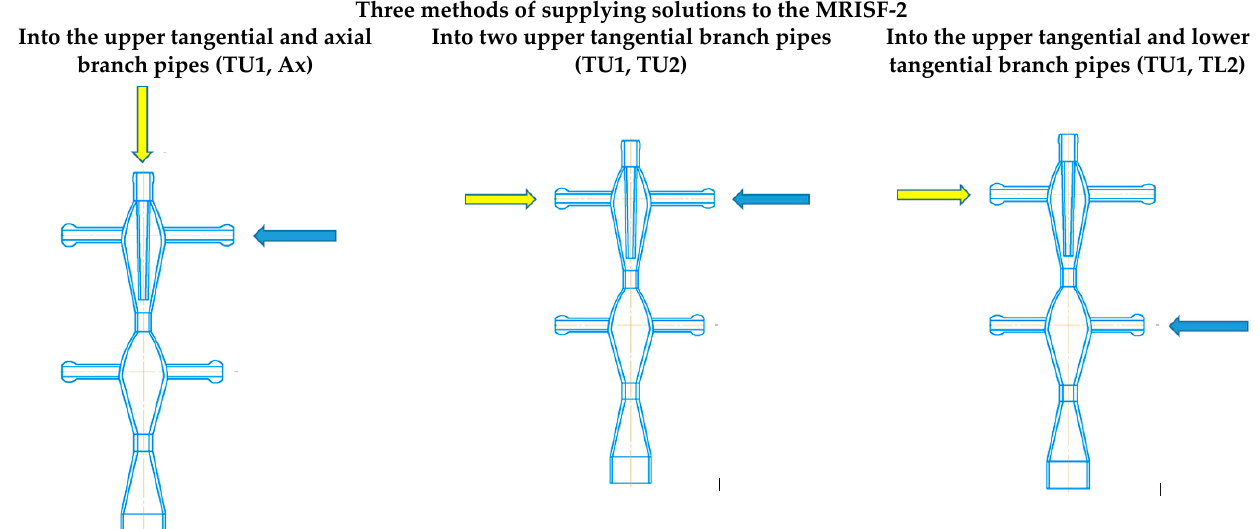
Table 2. Investigated methods of supplying liquids to the MRISF ‐ 2.